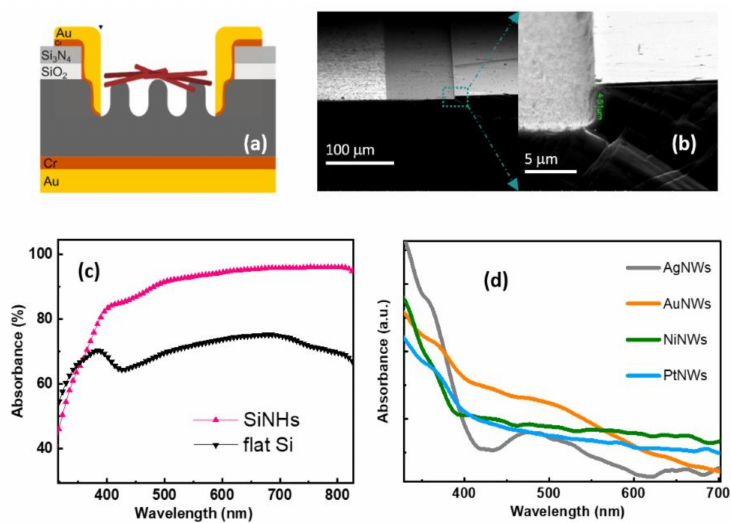
Figure 2. ( a ) Schematic diagram of the optical device based on MeNWs/SiNHs heterojunction. ( b ) Tilt-view SEM image of top Au/Cr layers contacting the SiNHs (left side) and the magnified image of the selected area showing the depth of the oxide window (right side). ( c ) Absorbance spectra of the silicon surface before and after nanoholes’ formation ( d ) and optical absorbance spectra of the colloidal metallic